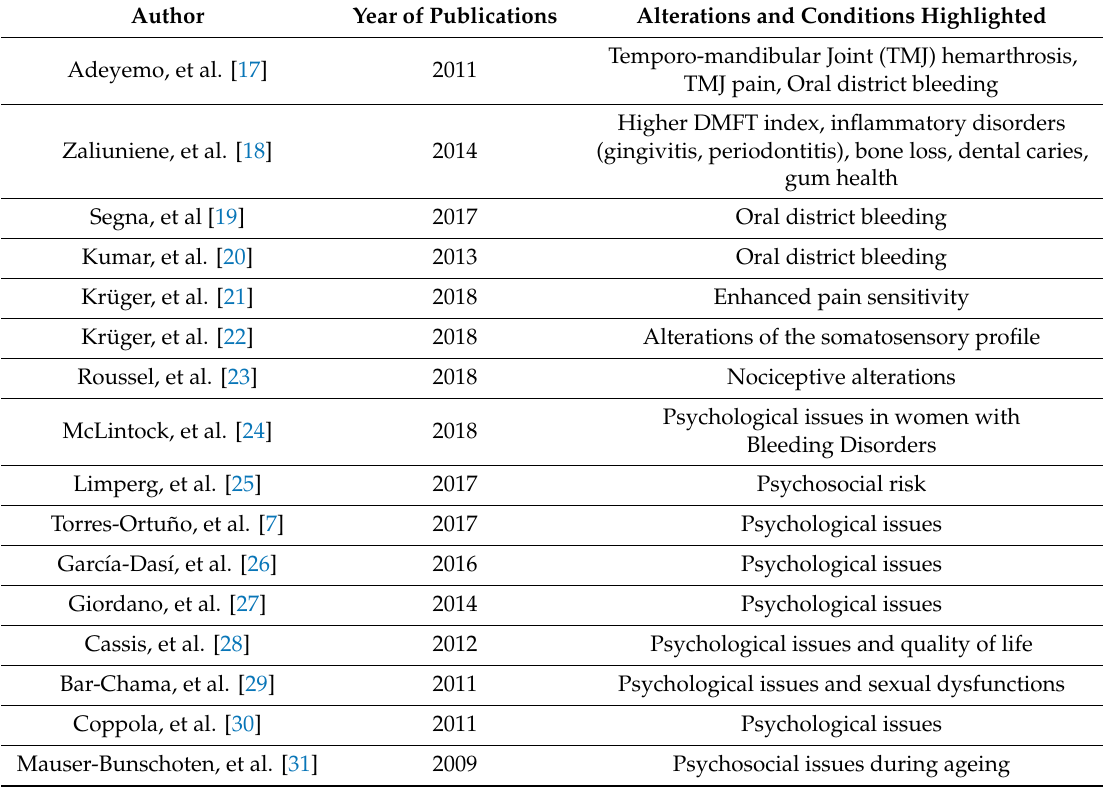
Table 1. Alterations highlighted in haemophiliac